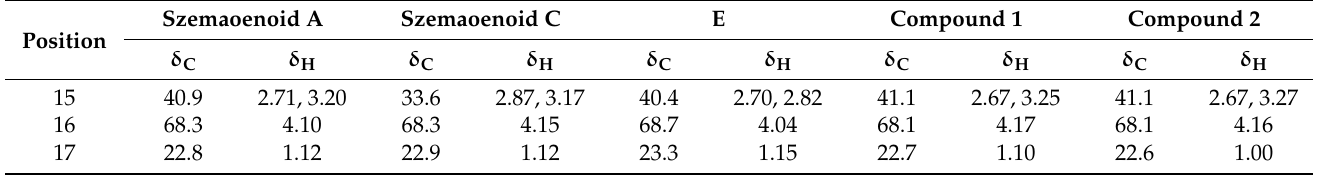
Table 3. Comparison of partial NMR data of 1 and 2 with known compounds a